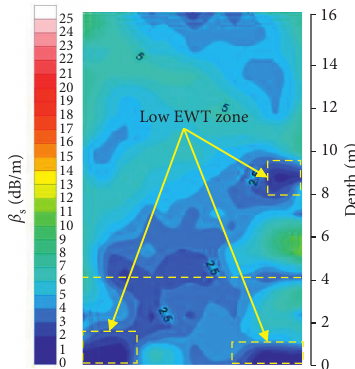
Figure 9: Electromagnetic CT image of station